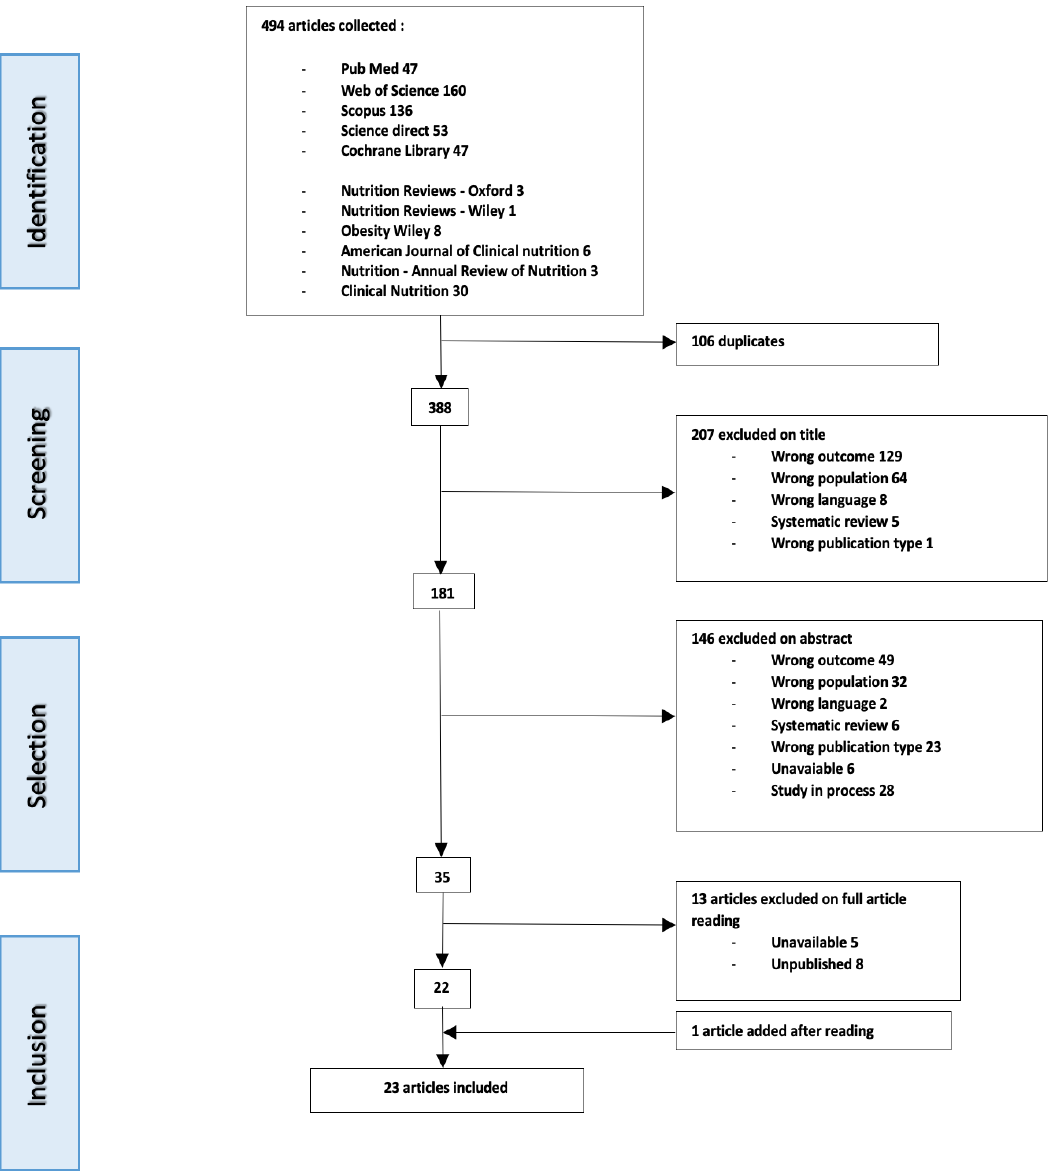
Figure 1. Flow chart of article selection strategy.